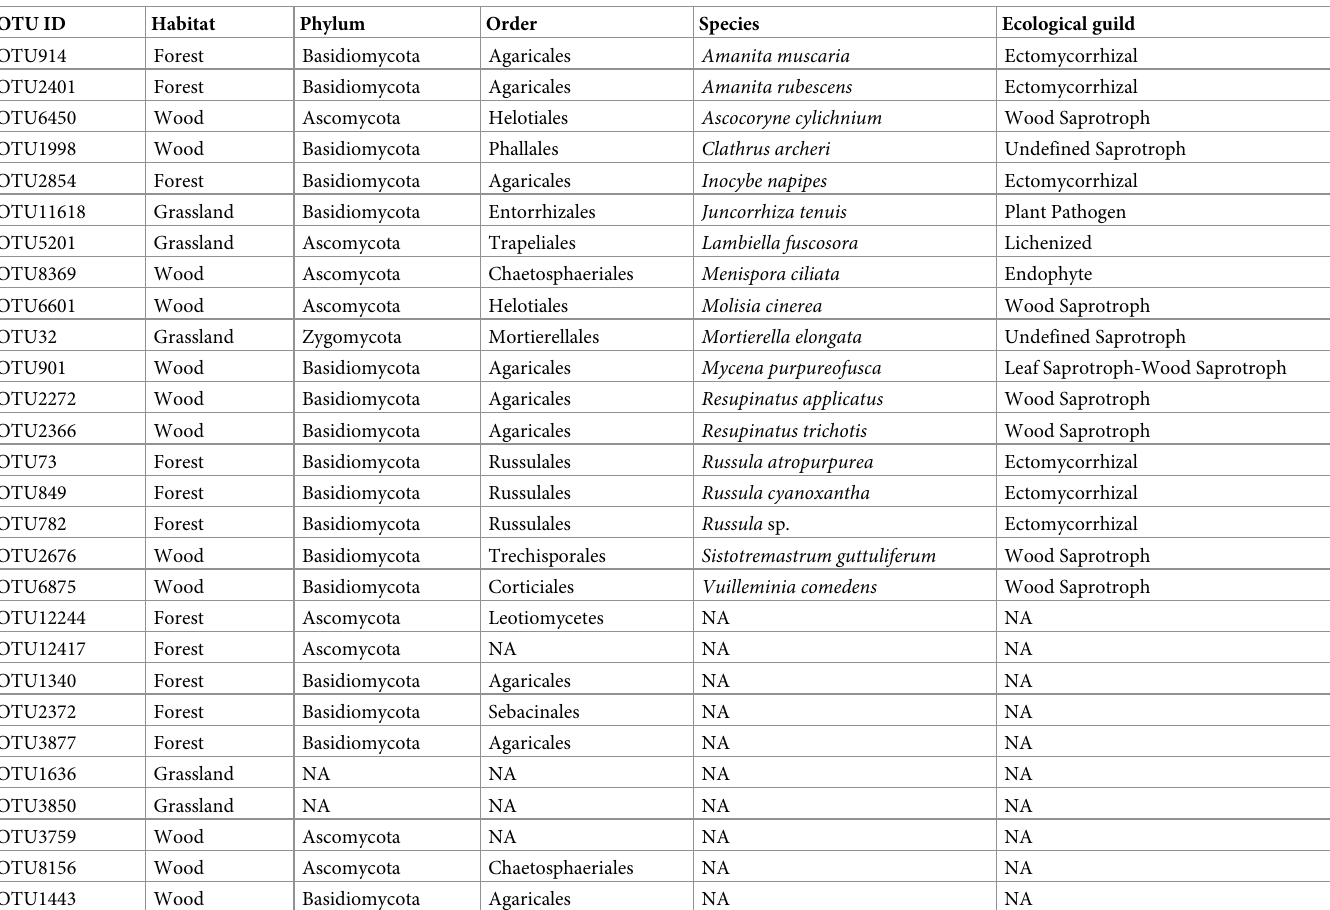
Table 3. Taxonomic origin and trophic modes of the differentially abundant MOTUs identified in the three habitats.